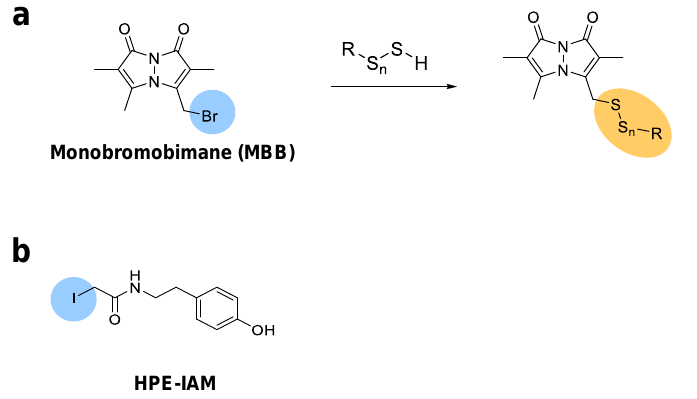
Figure 2. Chemical structures of MBB ( a ) and HPE-IAM ( b ), alkylating agents for LC-MS/MS analysis of hydropersulfides and hydropolysulfides.